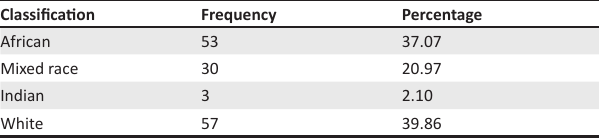
TABLE 5: Categorisation of race of sample. Classification